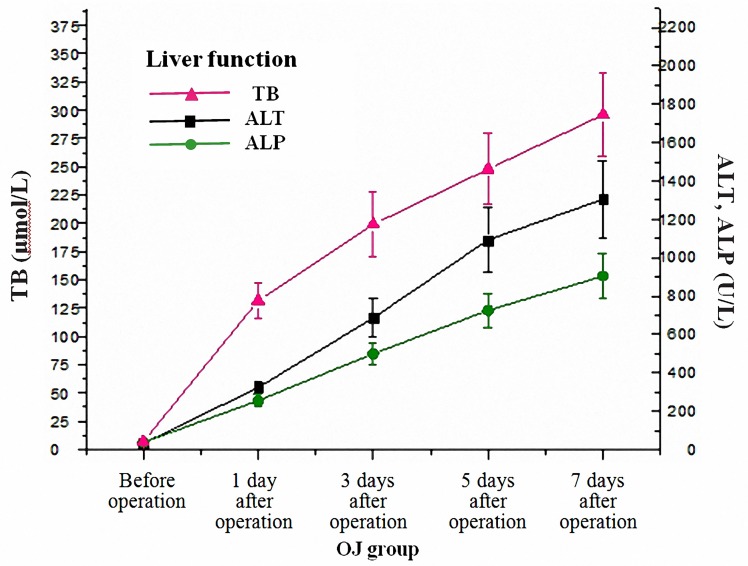
Changes of liver function in mice with time following BDL operation.